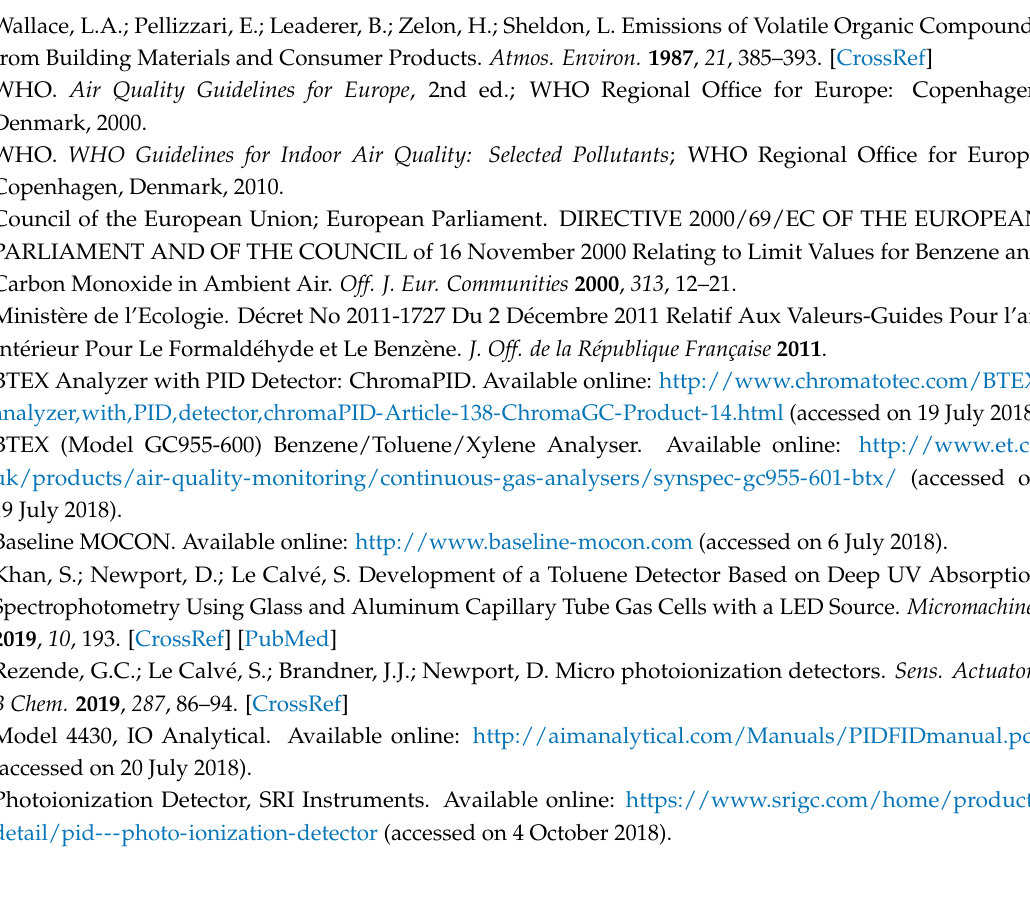
Figure S1: Leakage for three channel designs. Uncertainty varies from 1% at high flow rates to 5% at low